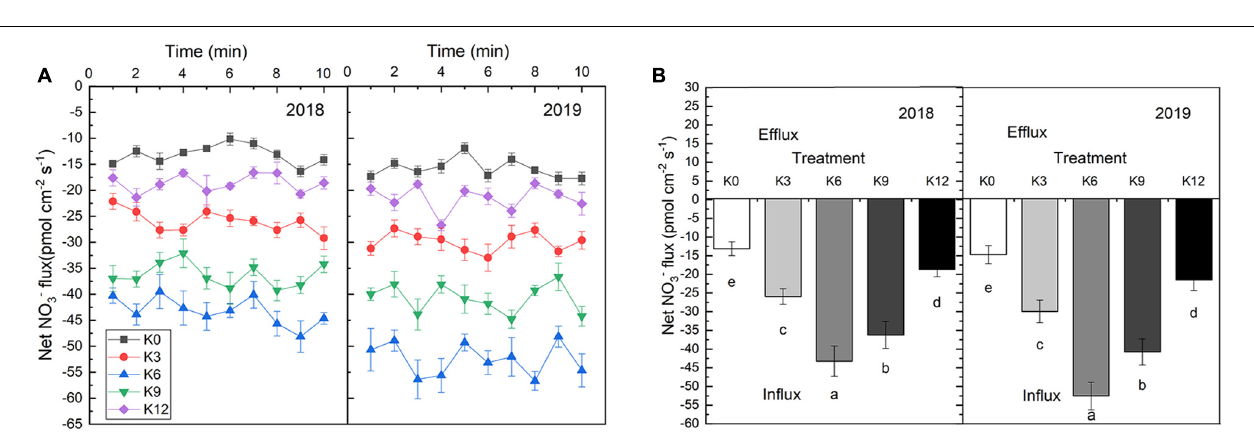
FIGURE 4 | 13 C accumulation (A) and 13 C distribution ratio (B) of M9T337 seedlings treated with K0 (0 mM K + ), K3 (3 mM K + ), K6 (6 mM K + ), K9 (9 mM K + ), or K12 (12 mM K + ) in 2018 and 2019. Each treatment had three biological replicates and the assays were repeated three times. Vertical bars indicate ± SD ( N = 3). Different letters indicate statistically significant differences ( P < 0.05).